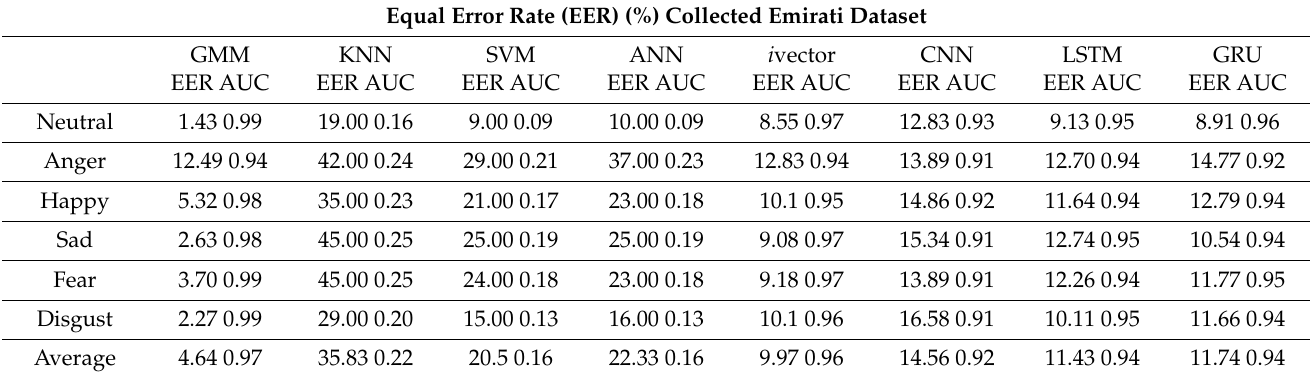
Table 2. Percentage EER values of classical and deep models using Emirati dataset. Equal Error Rate (EER) (%) Collected Emirati